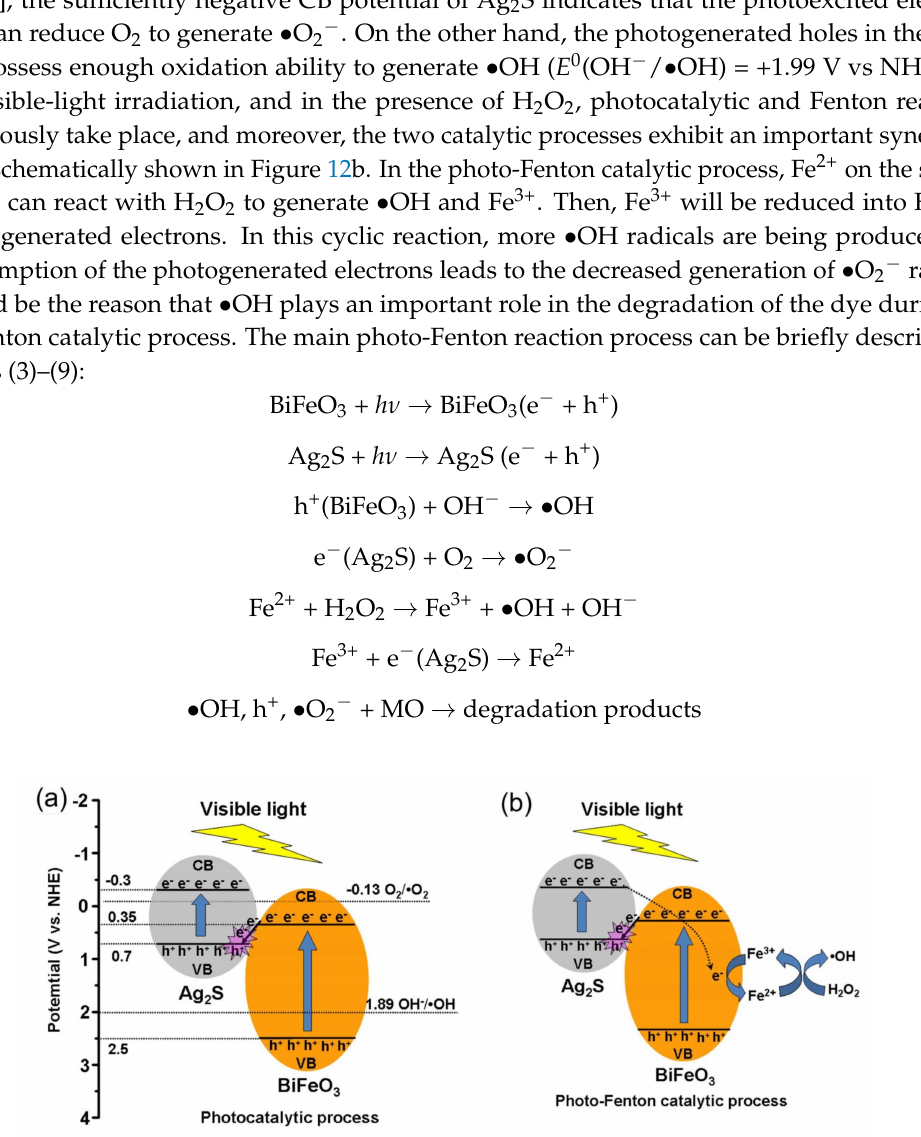
Figure 12. Schematic illustration of the degradation mechanism of MO over the Ag 2 S/BiFeO 3 composites. ( a ) The photocatalytic process; ( b ) the photo-Fenton catalytic